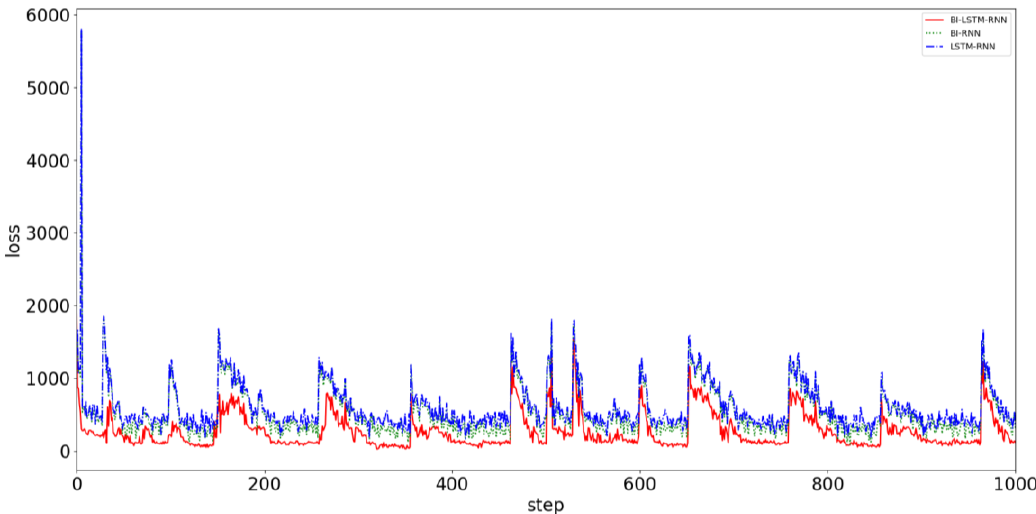
Figure 14. Convergence effects of three prediction models: BI-LSTM-RNN (red line), BI-RNN (green line), and LSTM-RNN (blue line).